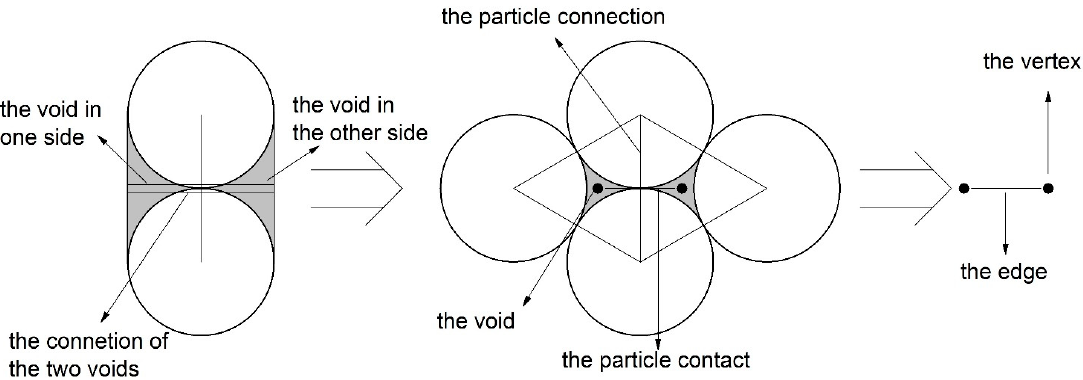
Figure 2. The characterization method of the particle contact and the abstracted graph.